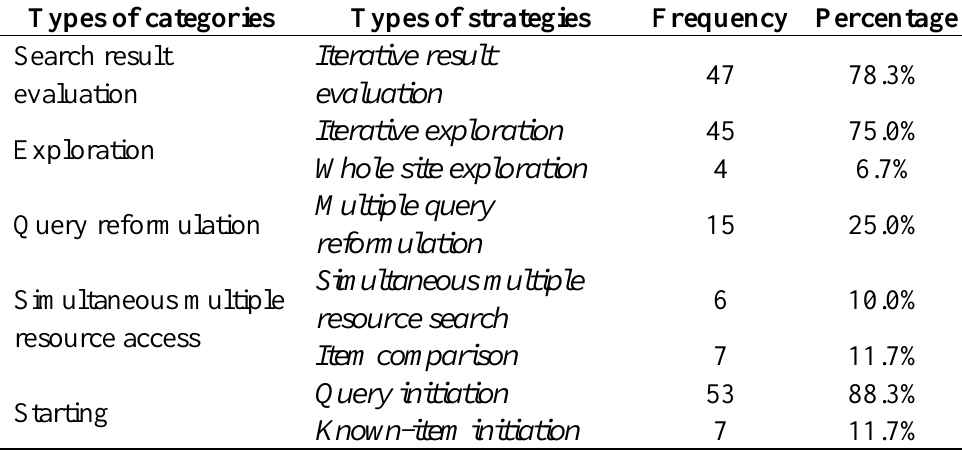
Table 4. Frequency of and percentage of strategies (N = 60